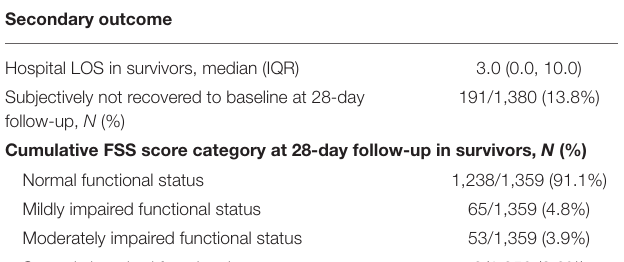
TABLE 3 | Secondary outcome measures for patients surviving at 28-day follow-up. Secondary